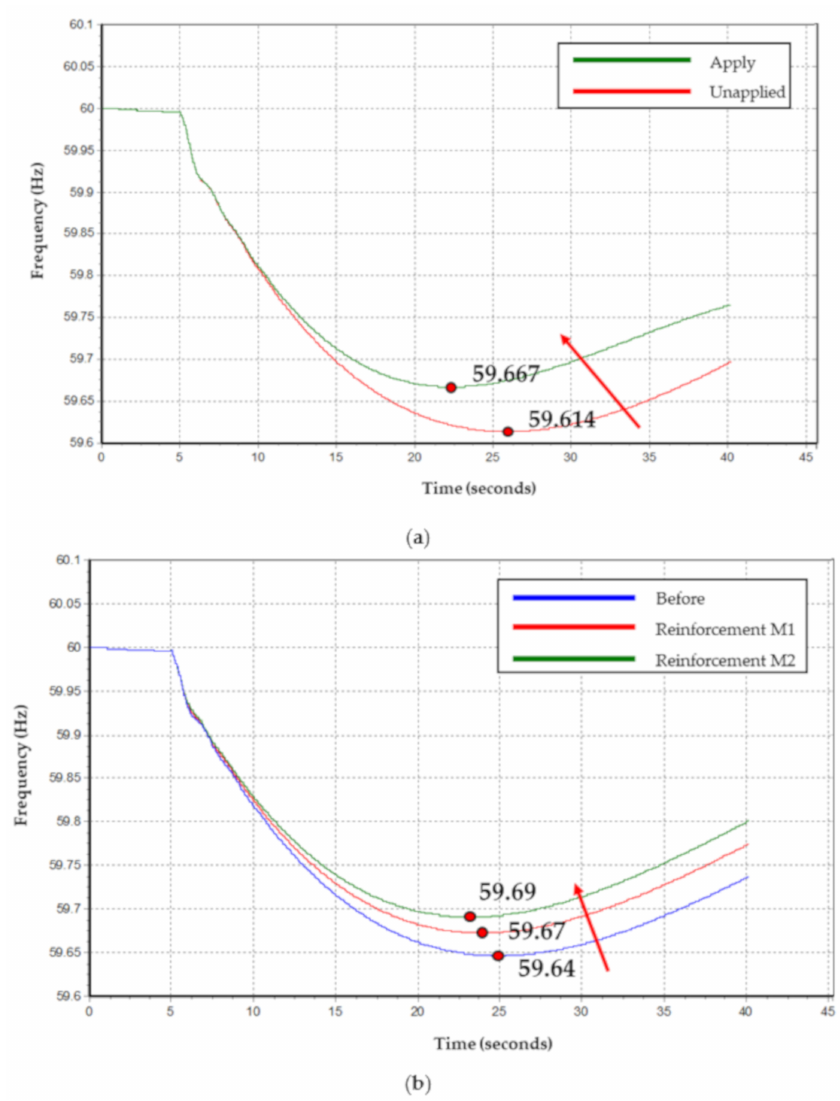
Figure 13. ( a ) Frequency response in the year of 2026 according to the application and non-application of a frequency response function for the wind generator in the Sinan region; ( b ) lowest frequency change according to the base status (before), reinforcement 1 and reinforcement 2 in the year of